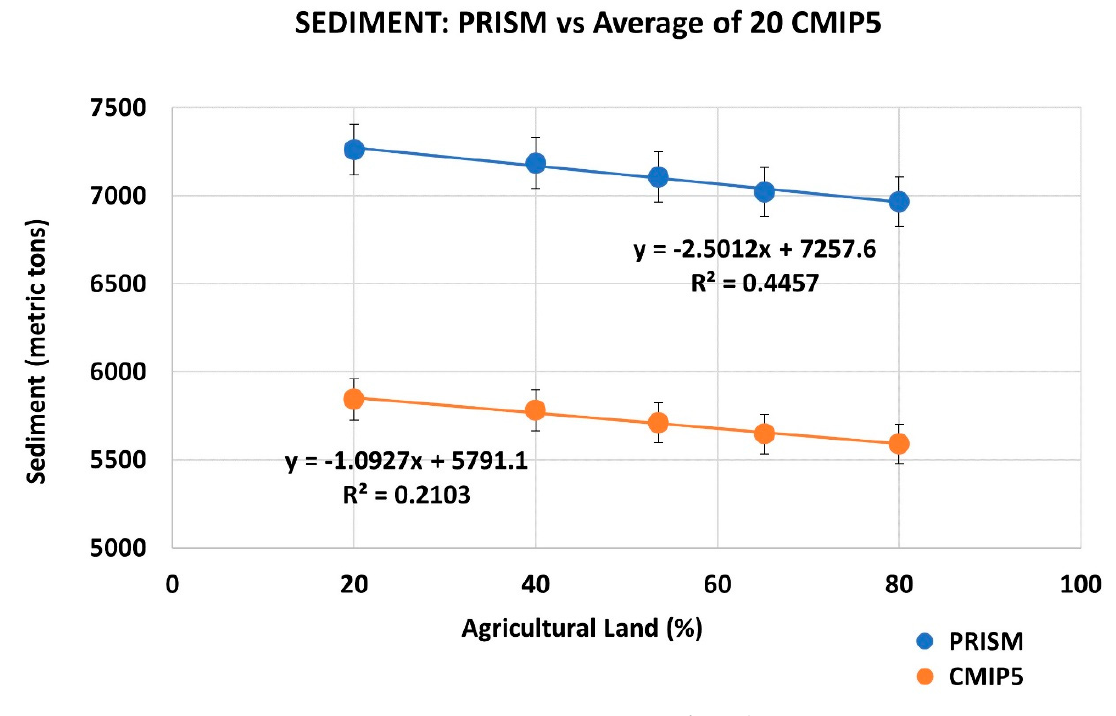
Figure 4. PRISM vs. 20 CMIP5 GCMs for sediment.